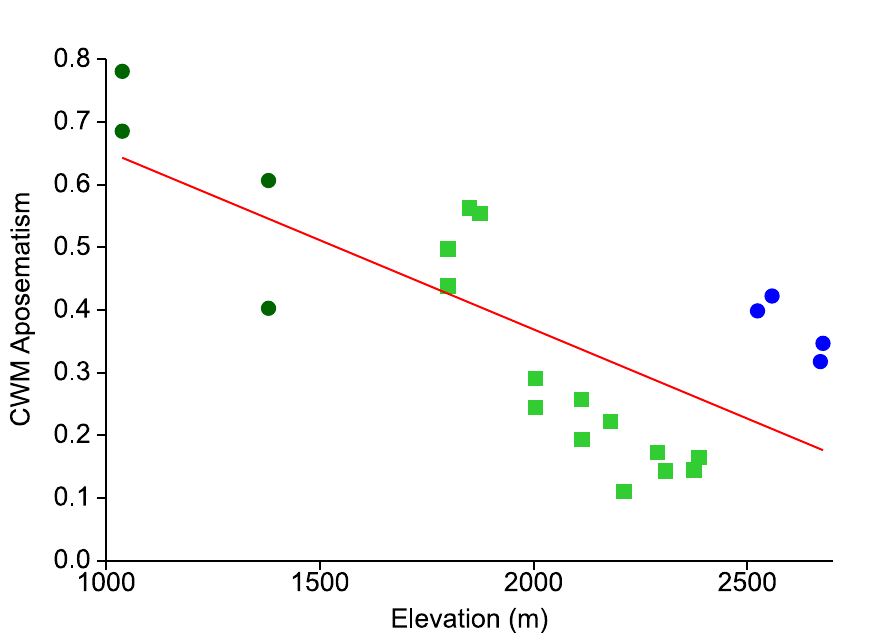
Figure 2. CWMs (Community Weighted Means) of aposematic coloration among 22 local Arctiinae assemblages in an elevational gradient in the Andes of southern Ecuador. Dark green dots: premon- tane forest; lime green squares: lower montane forest; blue filled circles: upper montane Purdiaea nutans forest. Forest types follow [22]. The red line represents an OLS regression.